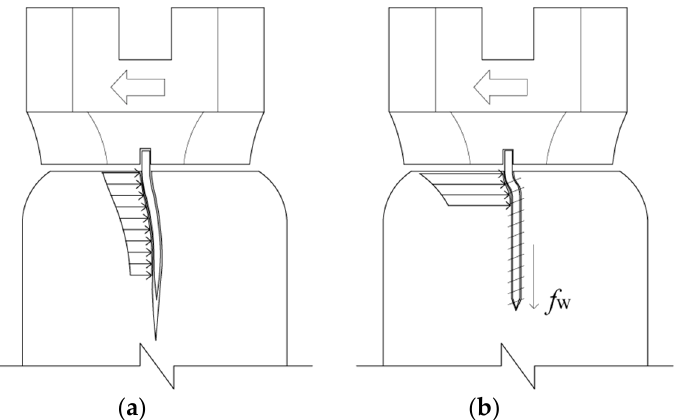
Figure 20. Deformation and stress distribution of bamboo nail and STS: ( a ) bamboo nail; ( b ) STS and its rope effect.